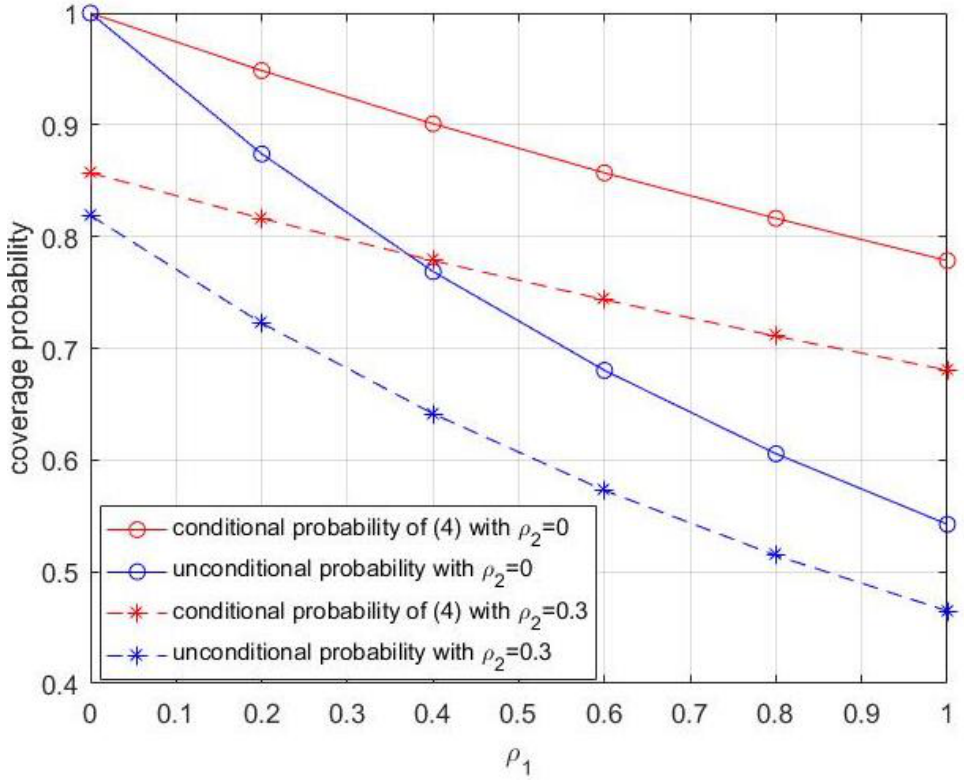
Figure 2. The coverage probability comparison between conditional and unconditional probability for different ρ 1 with λ 1 = 25/km 2